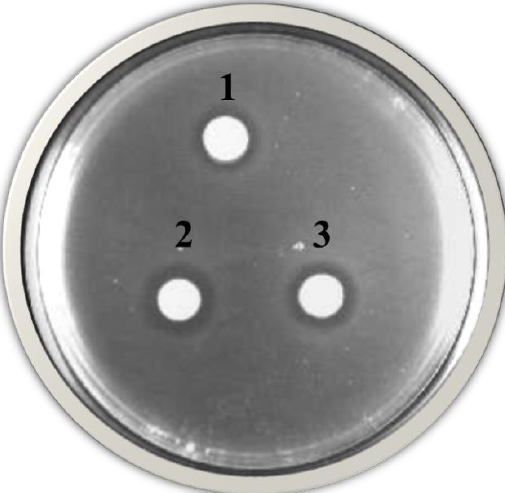
Figure 1. Growth inhibition activity of Candida pyralidae Y1117 (1), Pichia kluyveri Y1125 (2), and Pichia kluyveri Y1164 (3) against Dekkera anomala on grape pomace extract agar. One plate out of all the different treatments was selected for a visual representation of growth inhibition activity.